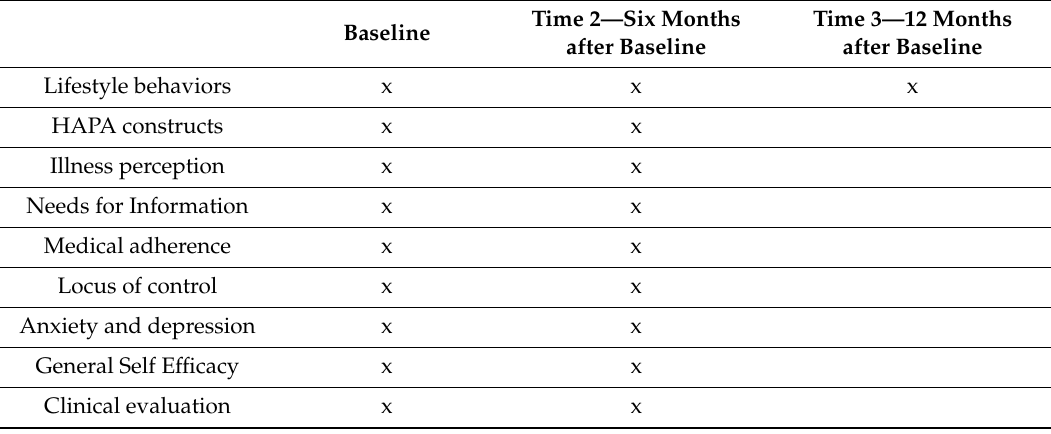
Table 1. Overview of measures over the di ff erent time points of the